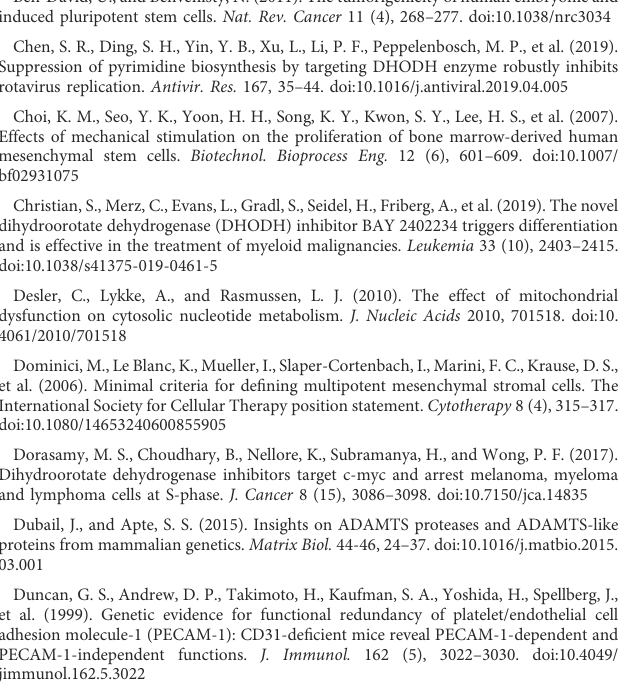
SUPPLEMENTARY FIGURE S1 Unaltered gene expressions of BRQ treated iMSCs (A) iMSCs treated for 7 days with BRQ or DMSO, hieratical clustering of samples of the signi fi cantly differentially expressed genes (100 nM BRQ vs. DMSO control), bright yellow color indicates higher expression of gene and dark blue for lower expression. (B) RT-qPCR of pathway markers for the 7 days BRQ-treated